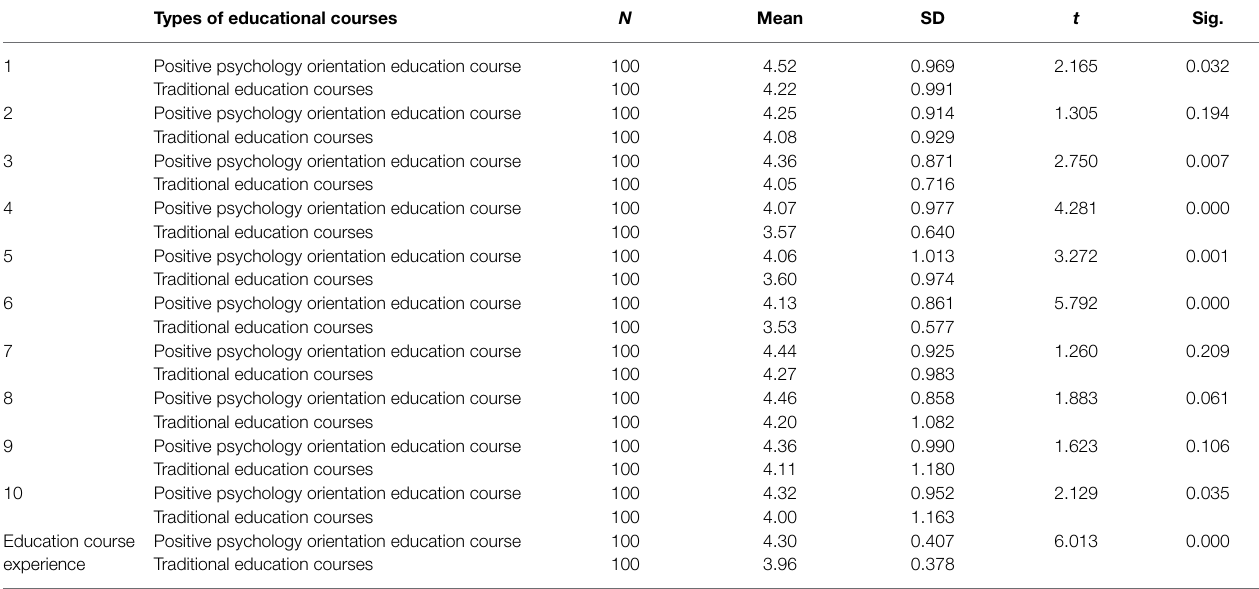
TABLE 2 | The results of the difference analysis of the educational curriculum feelings of participants in the educational curriculum reform in the direction of positive psychology and the traditional educational curriculum reform. Types of educational courses N Mean